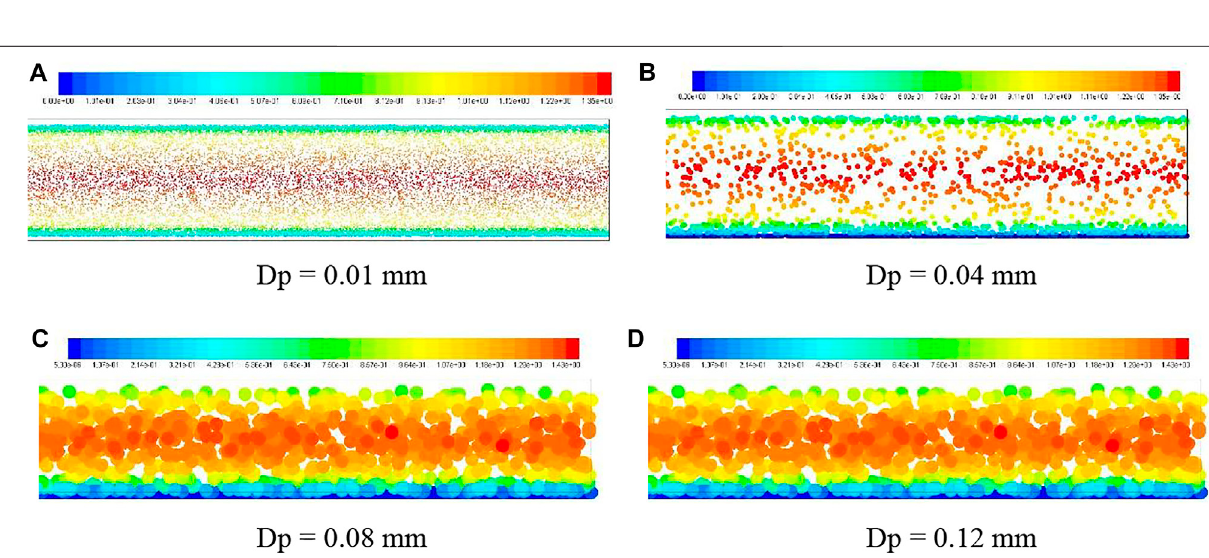
Frontiers in Physics |